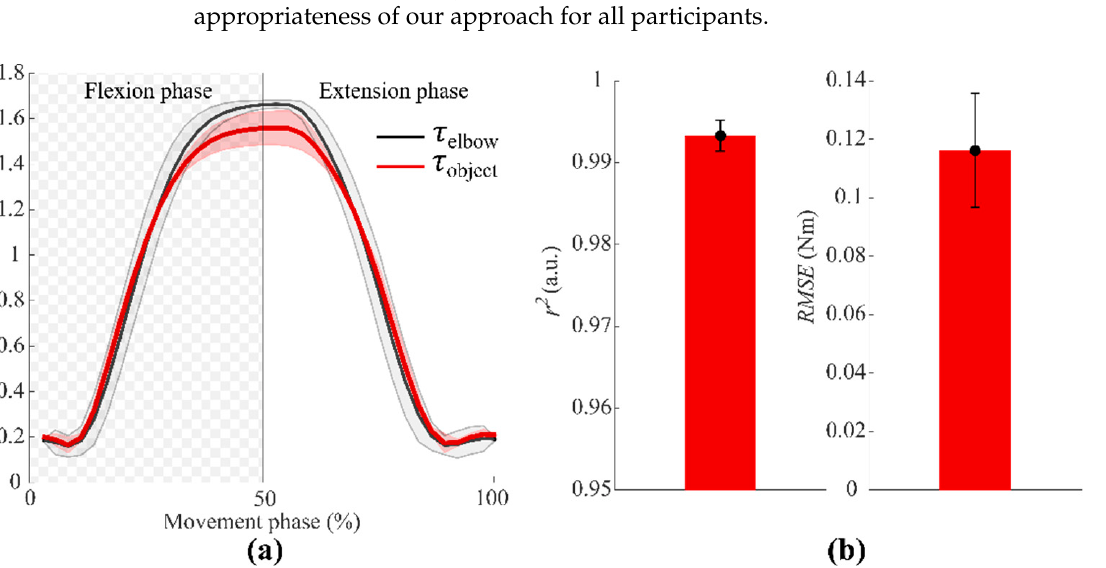
Figure 4. ( a ) Torque profile comparison (mean ± SE for a sample subject) between the torque obtained with the NMES condition ( τ elbow ) and the one obtained with the Physical condition ( τ object ). ( b ) r 2 (left) and RMSE (right) metrics to evaluate the accuracy of the torque comparison.